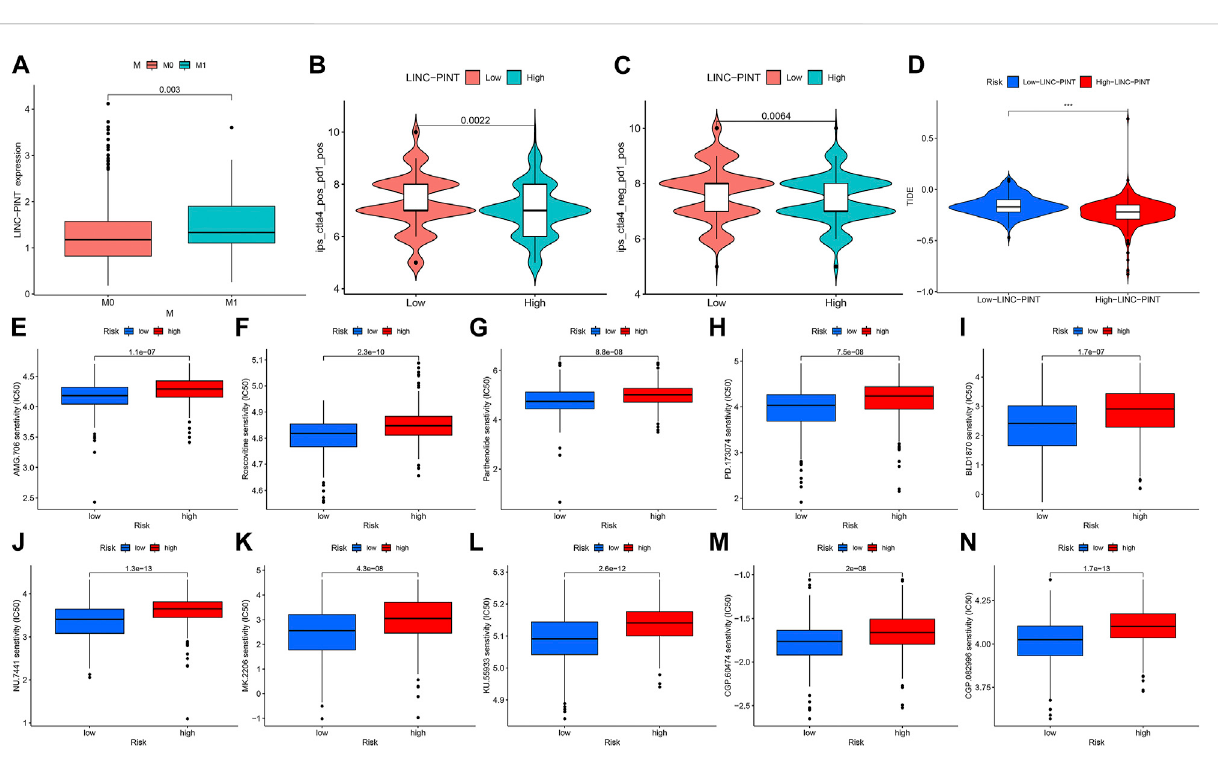
FIGURE 2 Relationship between LINC-PINT and clinical characteristics of patients with COAD. (A) Boxplot of differences in LINC-PINT expression levels between metastatic and non-metastatic groups of COAD patients. M0: non-metastasis; M1: tumor metastasis. (B, C) The immunophenotype scores in thelow-LINC-PINTgroupandhigh-LINC-PINTgroup. (D) TheTIDEscoredistributionbetweenhigh-andlow-LINC-PINTgroups. (E – N) Drugsensitivity analysis of multiple chemotherapeutic drugs in the high LINC-PINT expression group and the low LINC-PINT expression group,